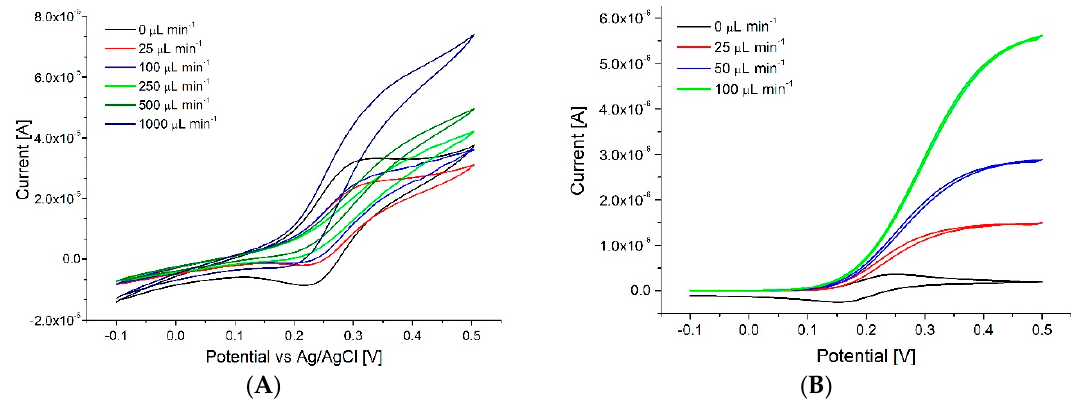
Figure 3. ( A ) Cyclic voltammetry studies of oxidation of FcDM performed for different flow rates (0– 1000 µL min − 1 ). Electrode cell consisted of a 3D working electrode formed from 16 graphite posts, steel counter electrode and an Ag/AgCl reference. Scan rate 100 mV s − 1 . ( B ) Calculated cyclic voltammograms for the 16 electrode post system.